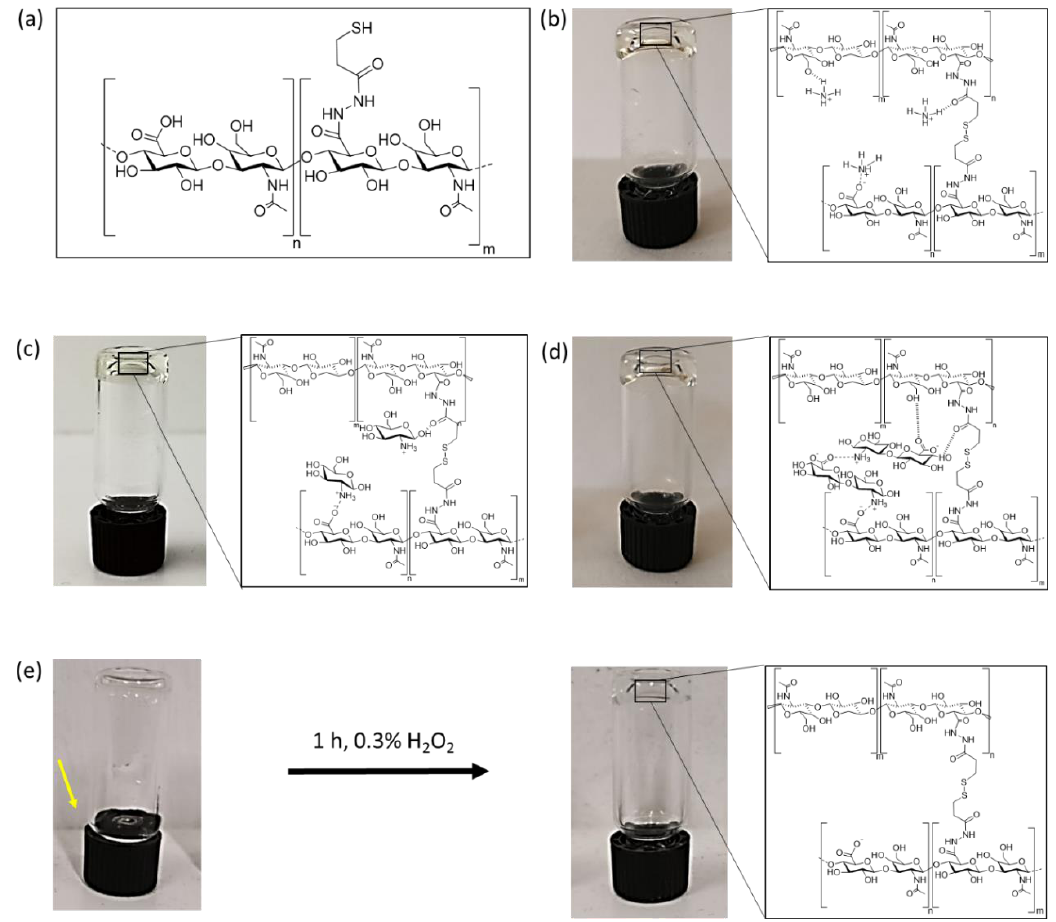
Figure 1. Inverted tube test utilized for hydrogel synthesis with and without ionic cross-linker. ( a ) Chemical structure of thiol functionalized HA; ( b ) thiol functionalized HA (HA-DTPH 29% ) with NH 4 + , ( c ) HA-DTPH 29% with GluA + , ( d ) HA-DTPH 29% with dHA + and ( e ) HA-DTPH 29% oxidized with H 2 O 2 .